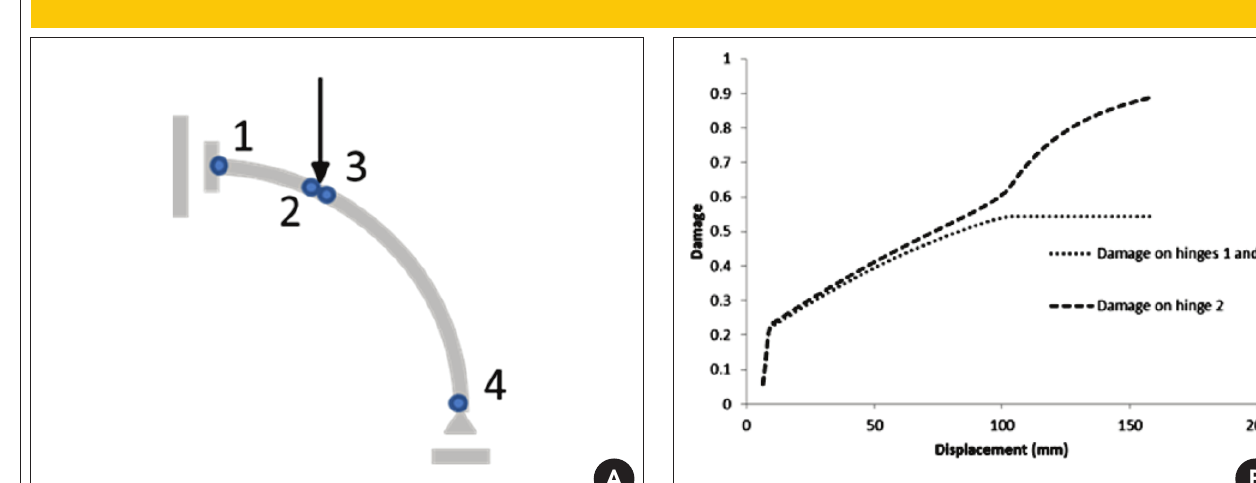
Figure 20 – Damage evolution on inelastic